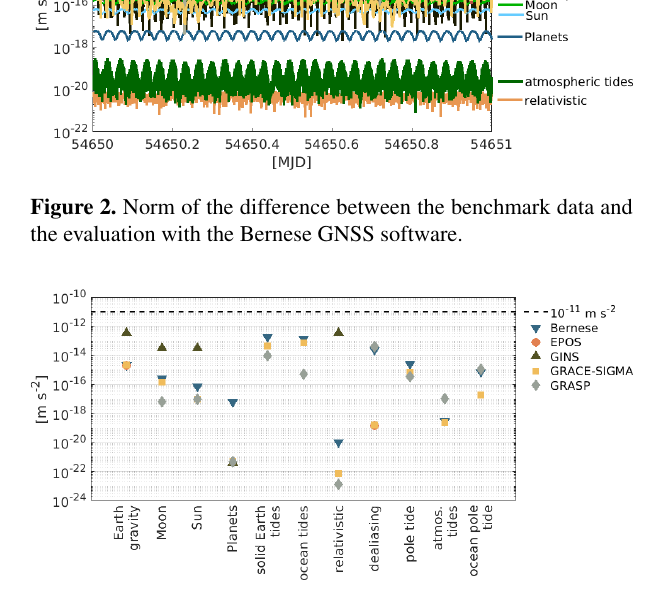
Figure 3. Maximum absolute deviation of the difference between the reference and the evaluation by the respective software of the COST-G ACs for each force considered in the benchmark data